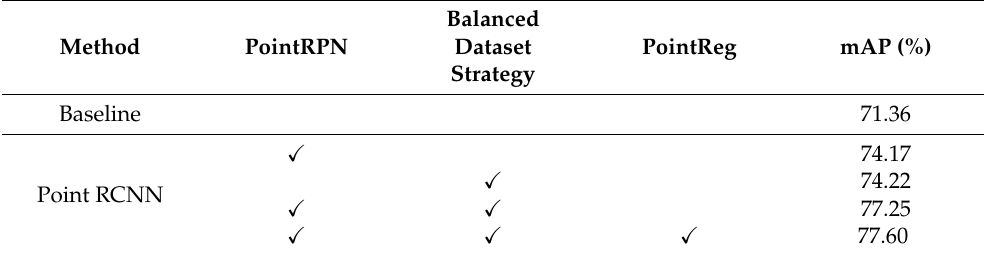
Table 9. Factor-by-factor ablation experiments. The detection performance was evaluated on the test set of DOTA-v1.5